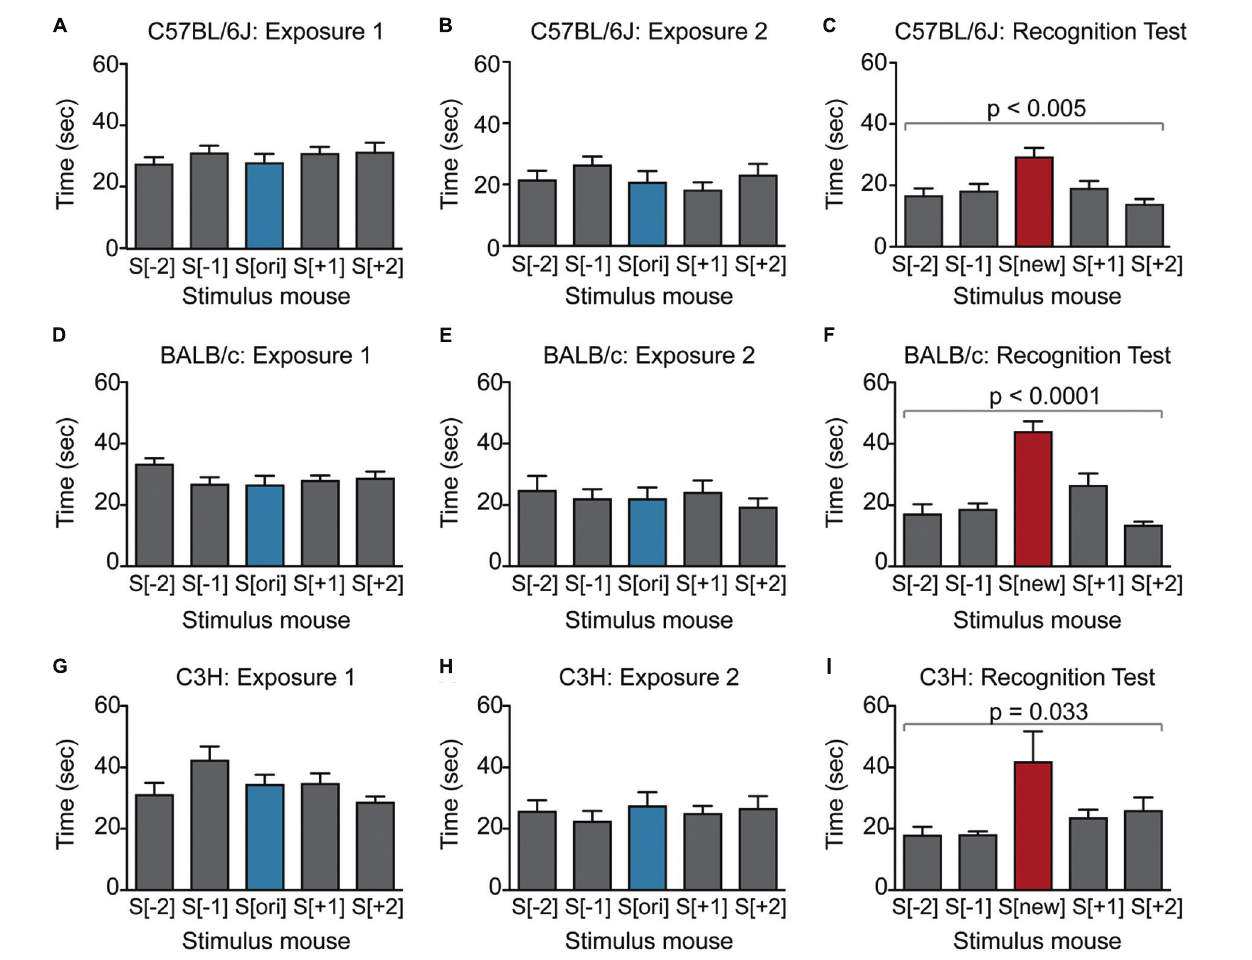
FIGURE 2 | Male mice from multiple strains show robust social recognition for 5 stimulus mice in the SocioBox paradigm. (A–C) Interaction time of male C57BL/6J mice with each stimulus mouse during (A) exposure 1, (B) exposure 2, and (C) recognition test. (D–F) Interaction time of male BALB/c mice with each stimulus mouse during (D) exposure 1, (E) exposure 2, and (F) recognition test. (G–I) Interaction time of male C3H mice with each stimulus mouse during (G) exposure 1, (H) exposure 2, and (I) recognition test. Statistical analysis was conducted using one-way ANOVA, summarized in Table 2 . Data are expressed as interaction time in sec (mean ± SEM).